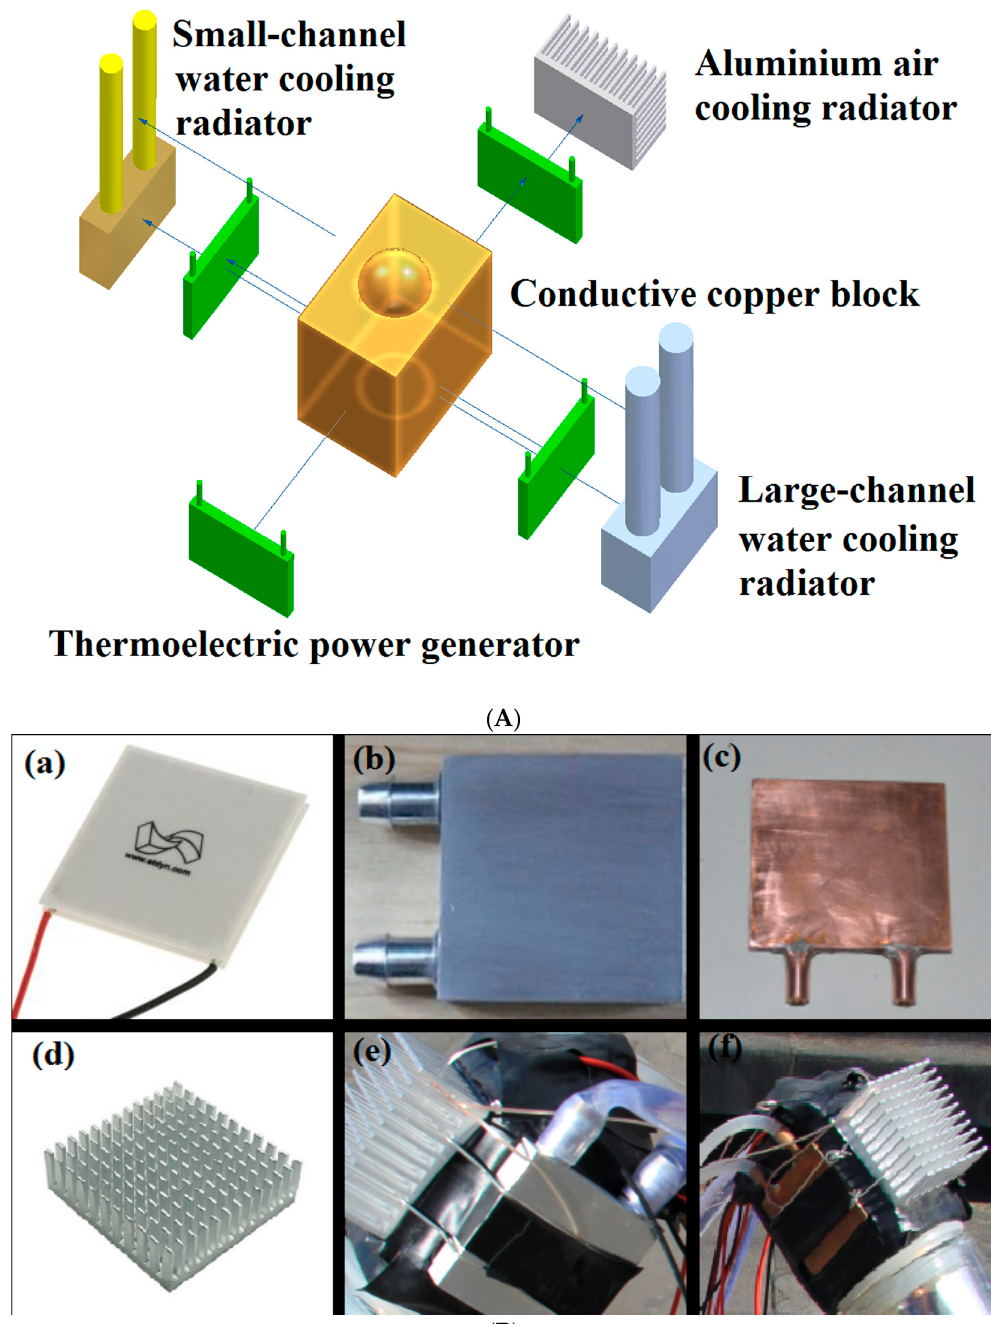
Figure 2. Cooling radiators of the device. ( A ) Schematic diagram; ( B ): (a) thermoelectric power generation module: GM ‐ 200 ‐ 127 ‐ 14 ‐ 16; (b) a large ‐ channel water ‐ cooling radiator; (c) a small ‐ channel water ‐ cooling radiator; (d) an aluminium air ‐ cooling radiator; (e) a picture of a large ‐ channel water ‐ cooling radiator and an aluminium air ‐ cooling radiator installed in the system; (f) a picture of a small ‐ channel water ‐ cooling radiator and an aluminium air ‐ cooling radiator installed in the system.